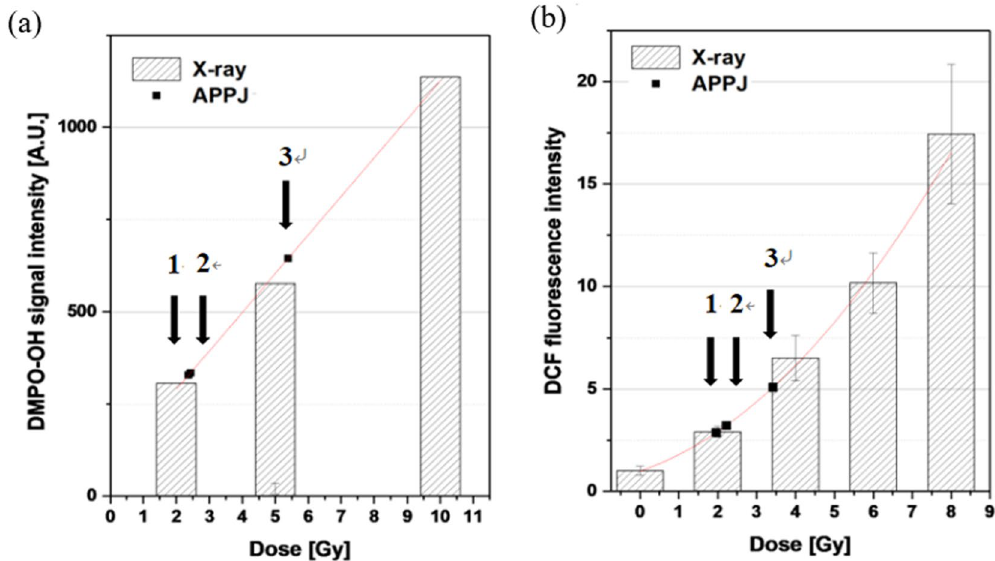
Figure 6. Effects of radiation exposure and plasma treatment in terms of ( a ) DMPO-OH signal intensity and ( b ) DCF fluorescence intensity. The DMPO-OH and DCF intensity data are fitted to a linear and a polynomial function, respectively. Arrows indicate the DMPO-OH and DCF intensities induced by plasma treatments under three operational setups (conditions 1, 2, and 3) of the APPJ device.